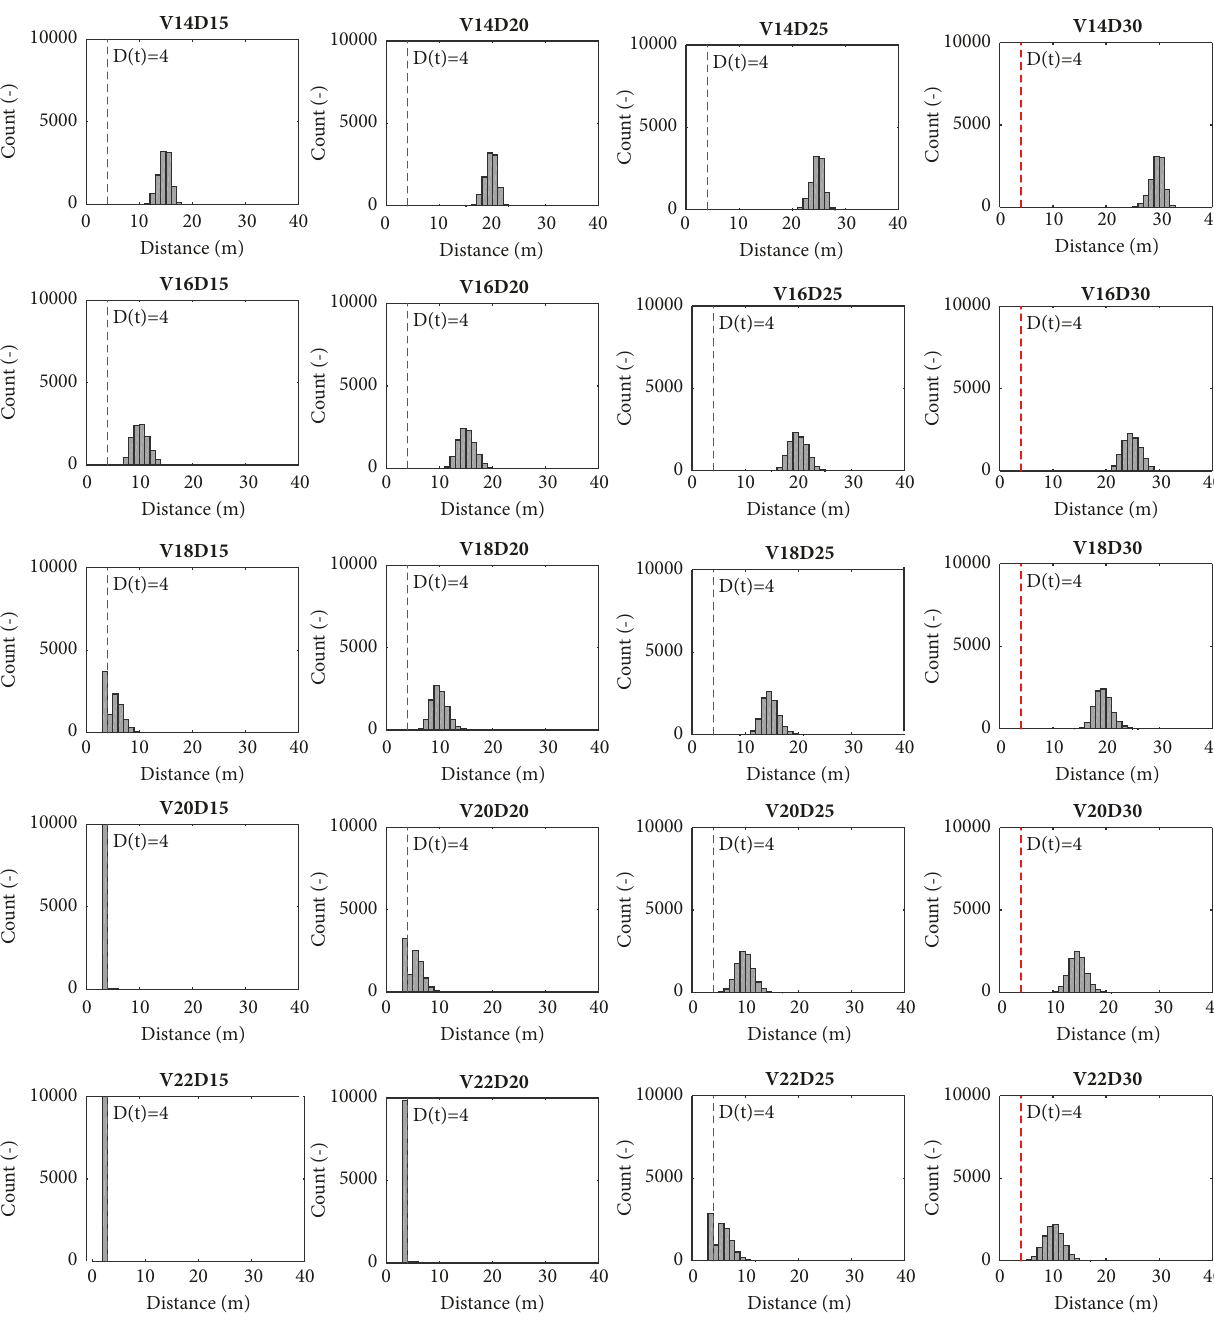
process with data collected by eye tracker, which may